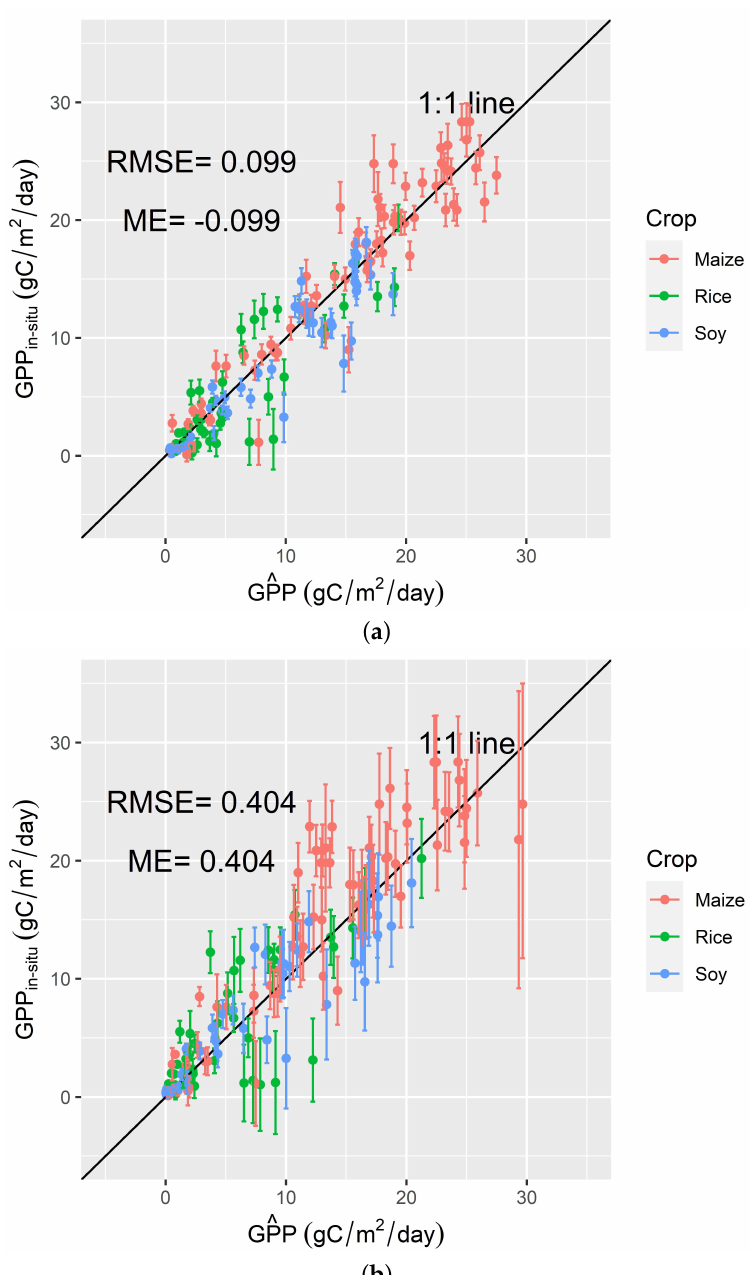
Figure 8. Predicted Gross Primary Productivity ( ˆ GPP ) with predicted light use efficiency ( ˆ LUE RF ) values from the model with ( a ) all predictor variables in Table 3 against GPP in situ from flux tower sites in Table 1, and ( b ) without crop type as a predictor. Root mean square error (RMSE) and mean error (ME) between observed and predicted observations are shown and the standard error on out-of-bag prediction is denoted by error